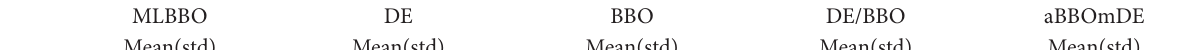
Table 6: Scalability study at Dim = 10, 50, and 100 after Dim ∗ 10,000 NFFEs for CEC 2005 test functions